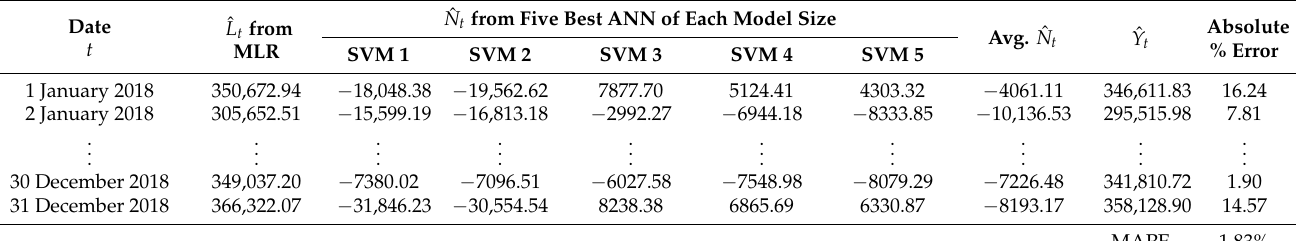
Table 12. Hybrid model of MLR and five best SVM.